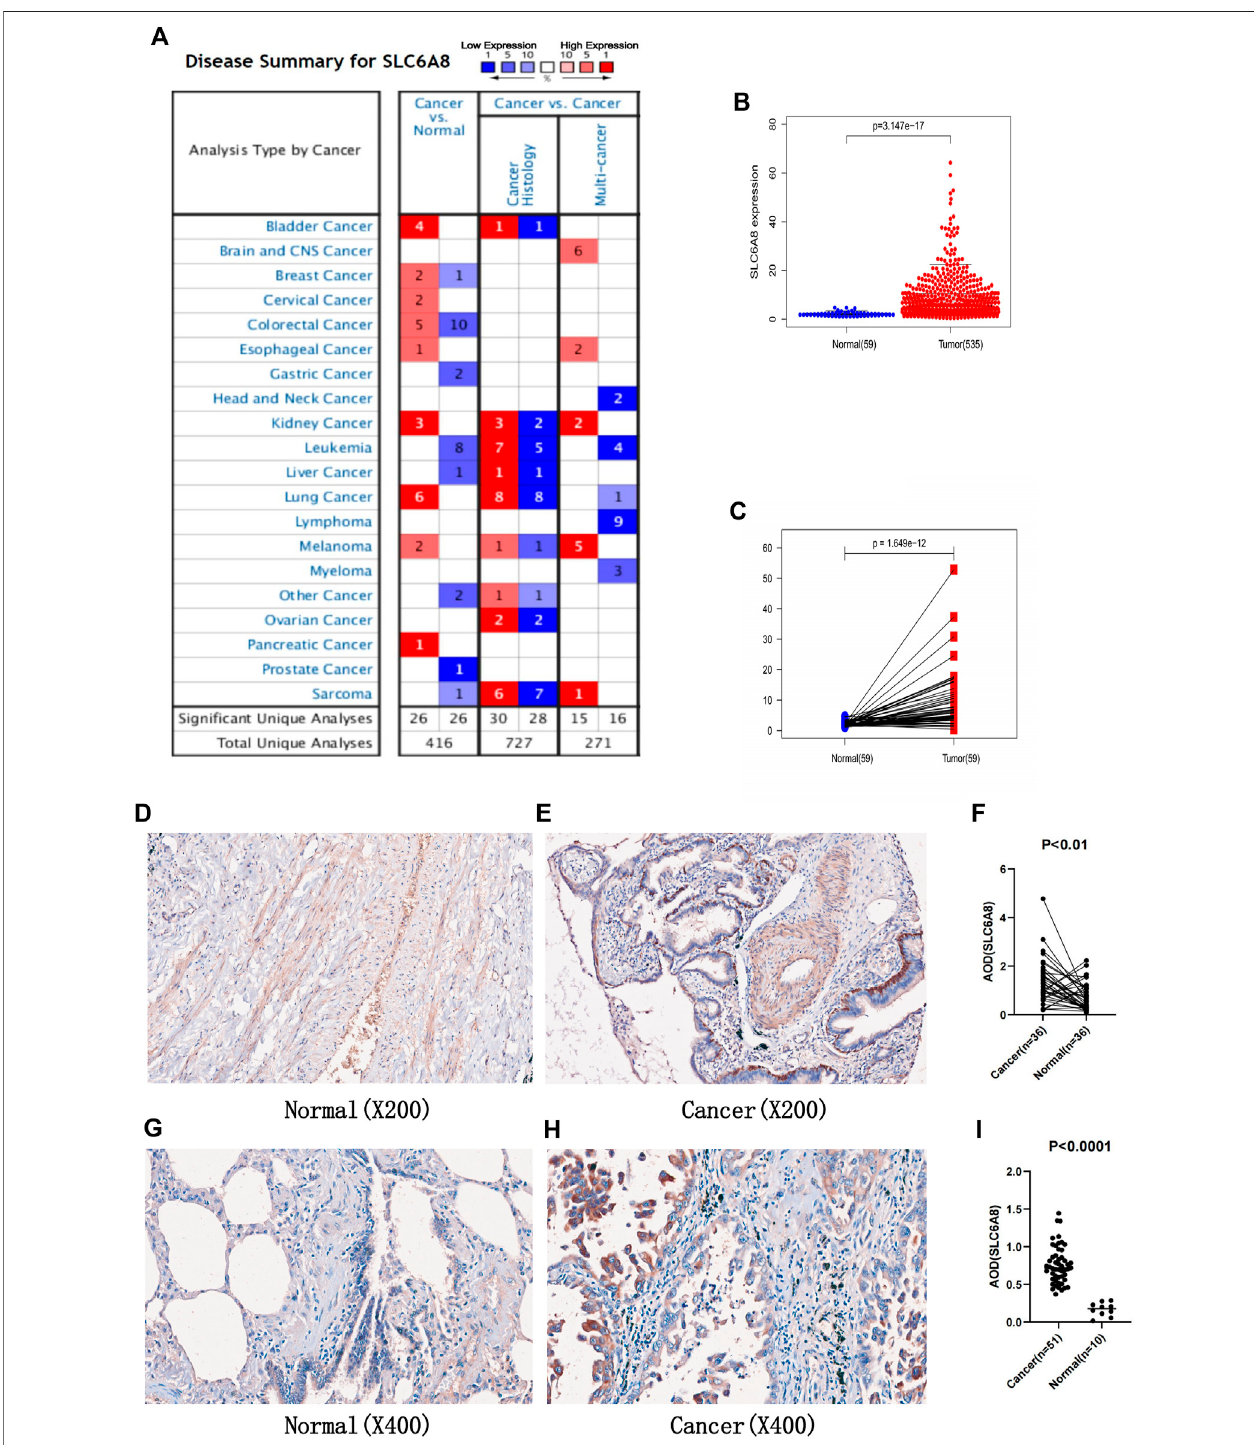
FIGURE 1 | Expression of SLC6A8 in tumors (A) Exprssion of SLC6A8 in pan-cancer in the Oncomine database. Numbersrepresent the number of studies. Red represent high expression. while blue represents low exprssion (B) Unpaired differential analysis and (C) paired differential analysis of SLC6A8 in LUAD in the TCGA database. (F) Analysisofpaireddifferencesbetween (D) normaland (E) LUADtissuesinTMA1immunohistochemicalstaining. (I) Analysisofunpaireddiffencesbetween (G) normal and (H) LUAD tissues in TMA2 immunohistochemical staining.